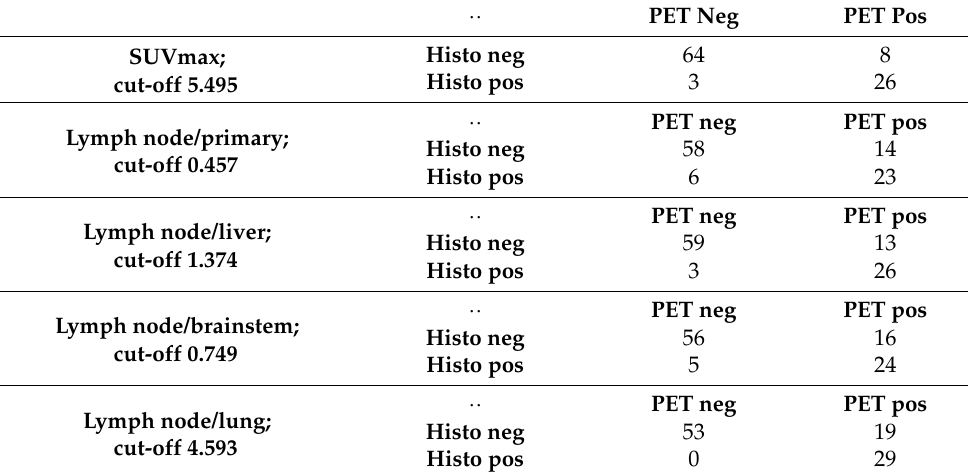
Table 4. Cross tables for the respective